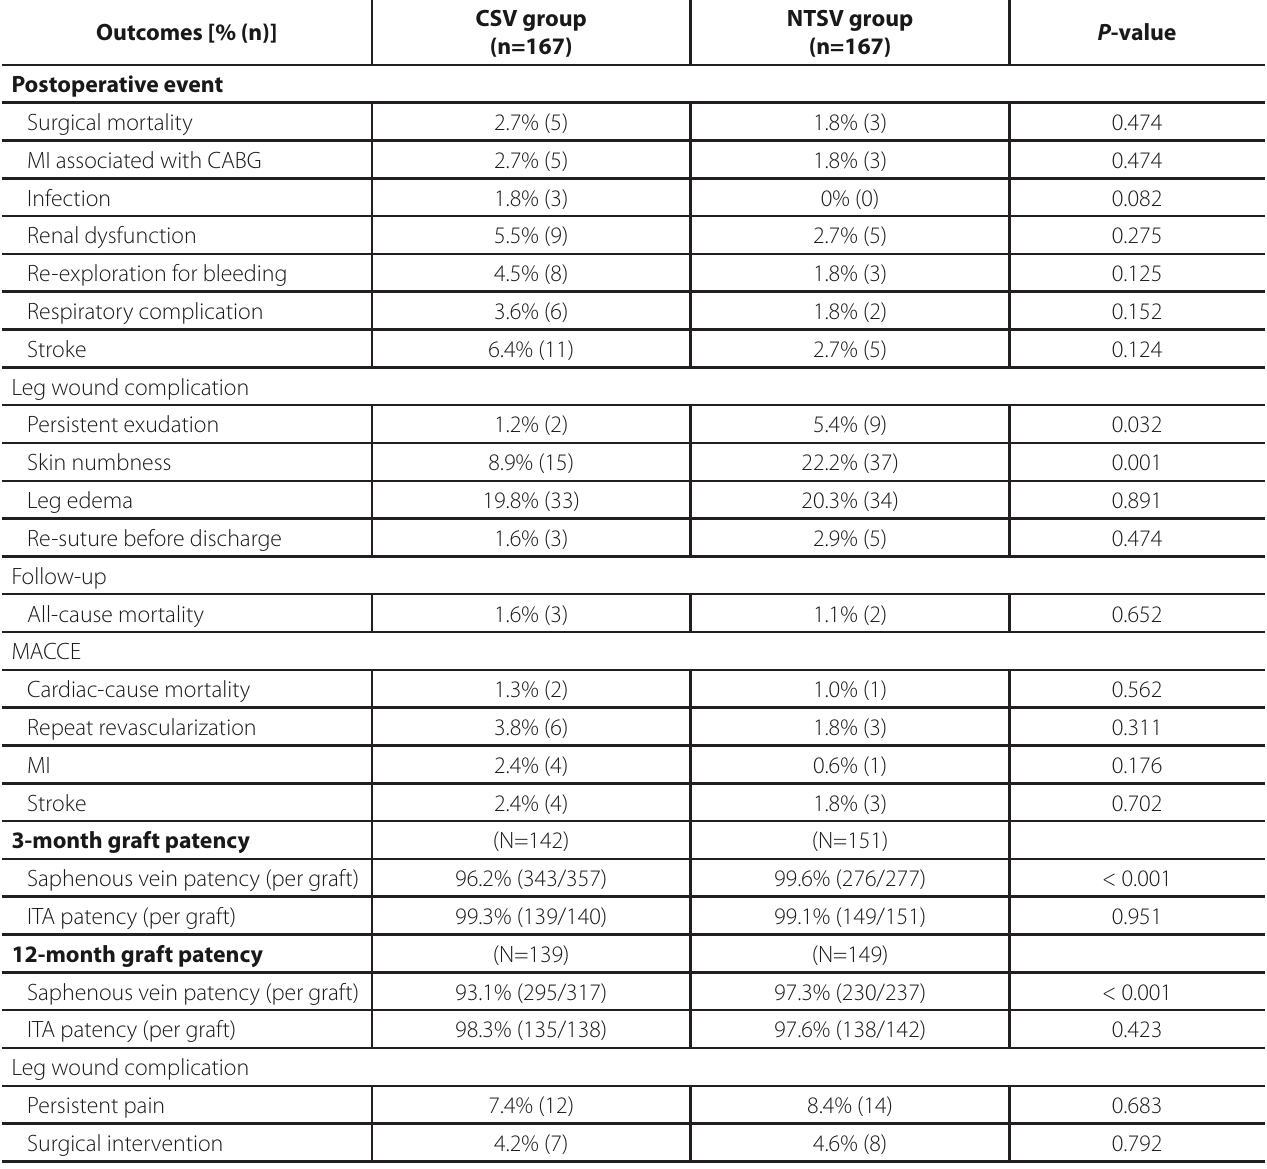
Table 3. Clinical outcomes for propensity-matched